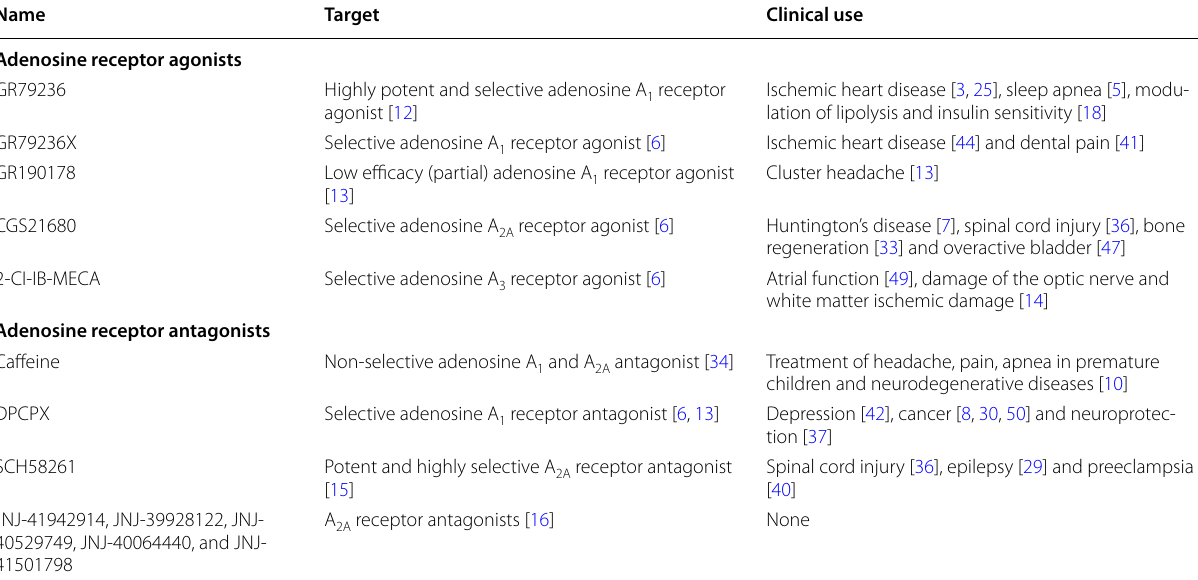
Table 2 Molecules presented here that target adenosine receptors. None are approved for